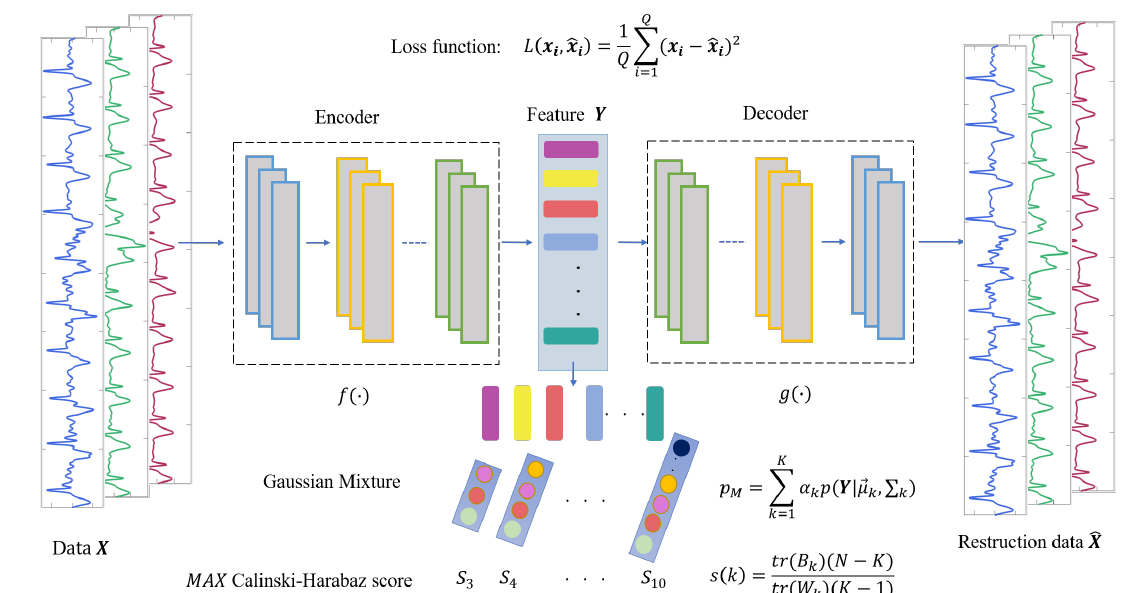
Figure 4. The structure of AE-GMM, which contains encoder and decoder convolution layers and Gaussian mixture clustering.